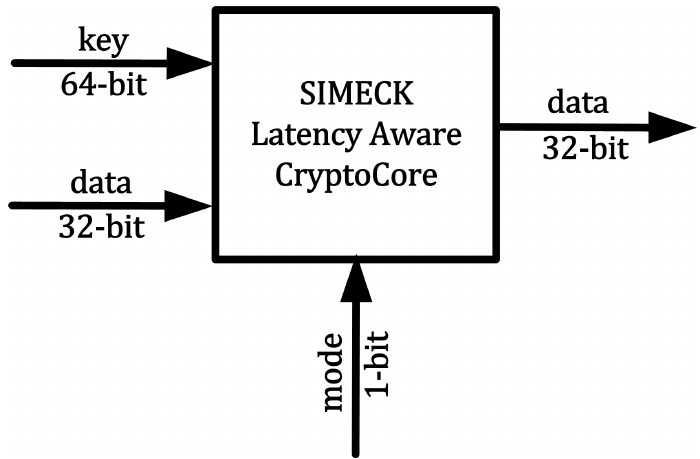
Figure 1. Block diagram of our SIMECK latency-aware